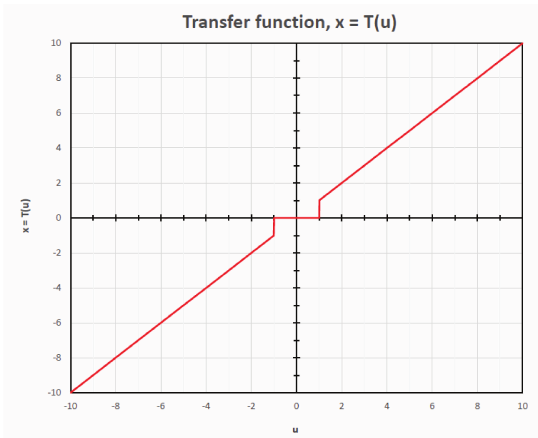
Figure 3. Thresholding function T ( x ) obtained from the circuit simulation of Figure 2 with V ref = 1.